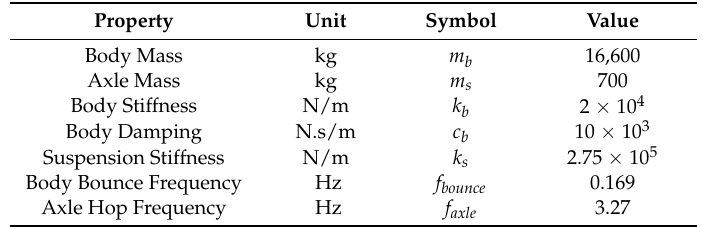
Table 2. Properties of the quarter car model.